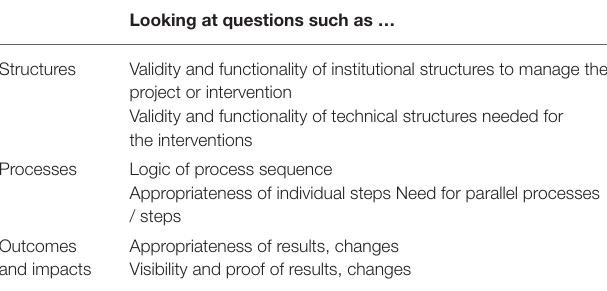
TABLE 3 | The aspects against which the 8Rs are